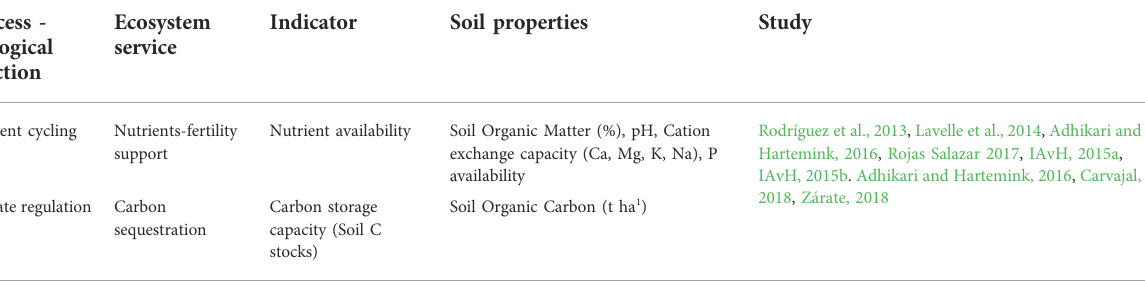
TABLE 1 Relationship of ecosystem services with their indicators and previous study sources. Orotoy river basin. Source: Elaborated by the authors. Process - ecological